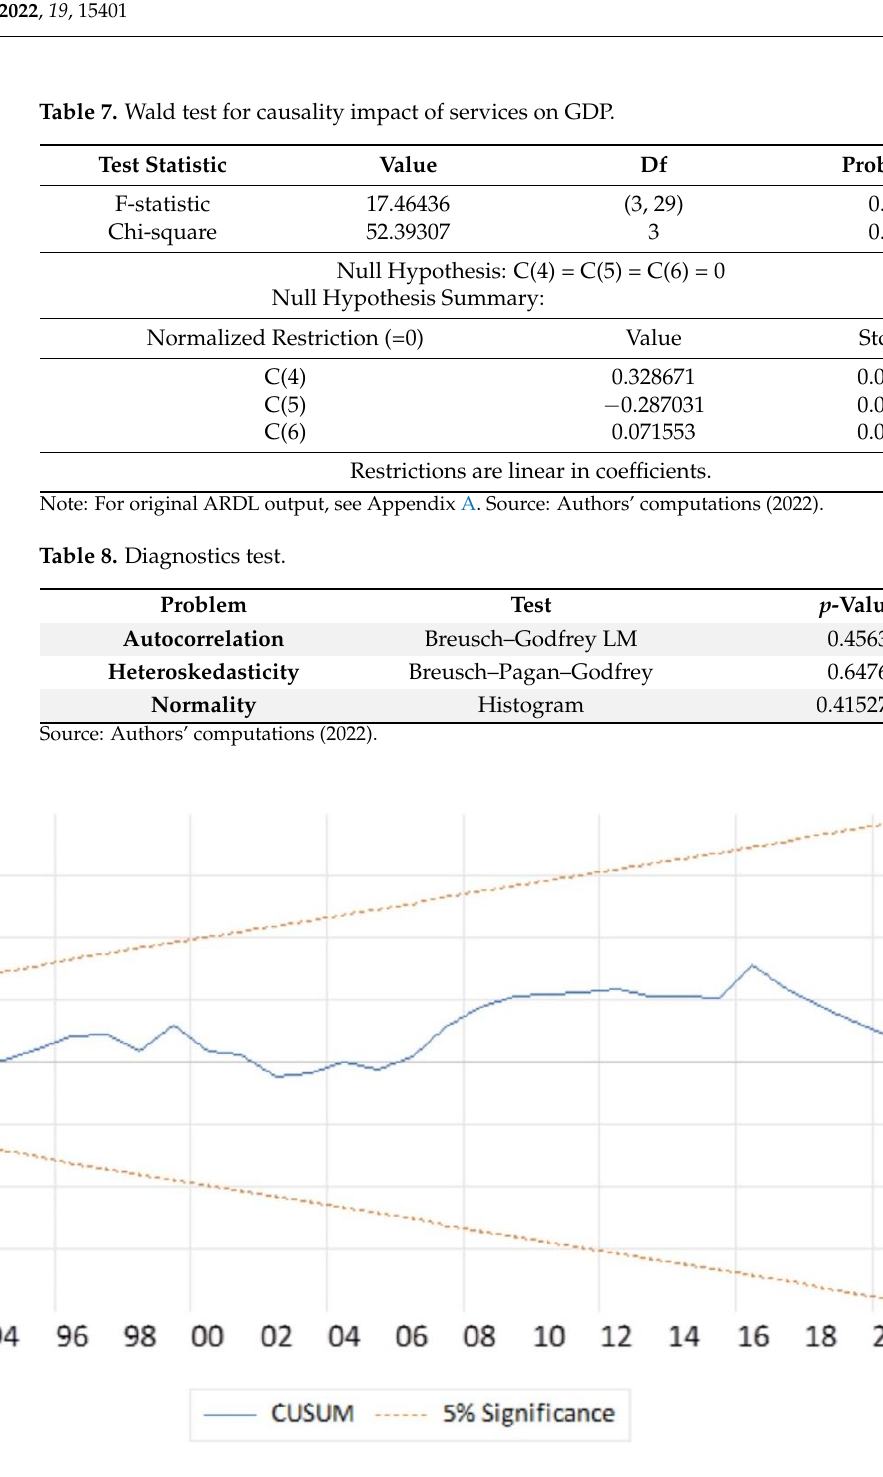
Figure 5. Stability test (Cusum squares test) . Source: Authors’ computations (2022). Table 7 and Figures 4 and 5 all indicate that the model is well-fitted and reliable for interpretation, predicting output, and making reliable policy recommendations. The services sector has been making huge contributions to the economy in terms of improvements in macroeconomic indicators such as national income, which has however been declining due to the recent persistence of the COVID-19 global pandemic. The suc- cess of the services sector has changed the economy in Botswana as it had been a source of economic growth and employment which has drastically improved the standards of living of people [15,16,28,41 – 44]. The sector ’ s growth has been of great benefit to the ever- growing large labor in Botswana through job creation. The demand for software acceler- ated investments in communications infrastructure-related industries such as IT-enabled services such as telecommunications supported other industries such as banking, insur- ance, hospitality, and aviation, which helped them grow. To achieve economic